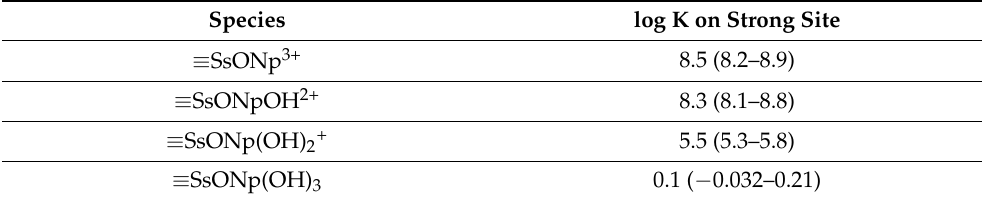
Table 5. Equilibrium constant of the surface complexation reaction for Np 4+ nuclide sorption on MX-80